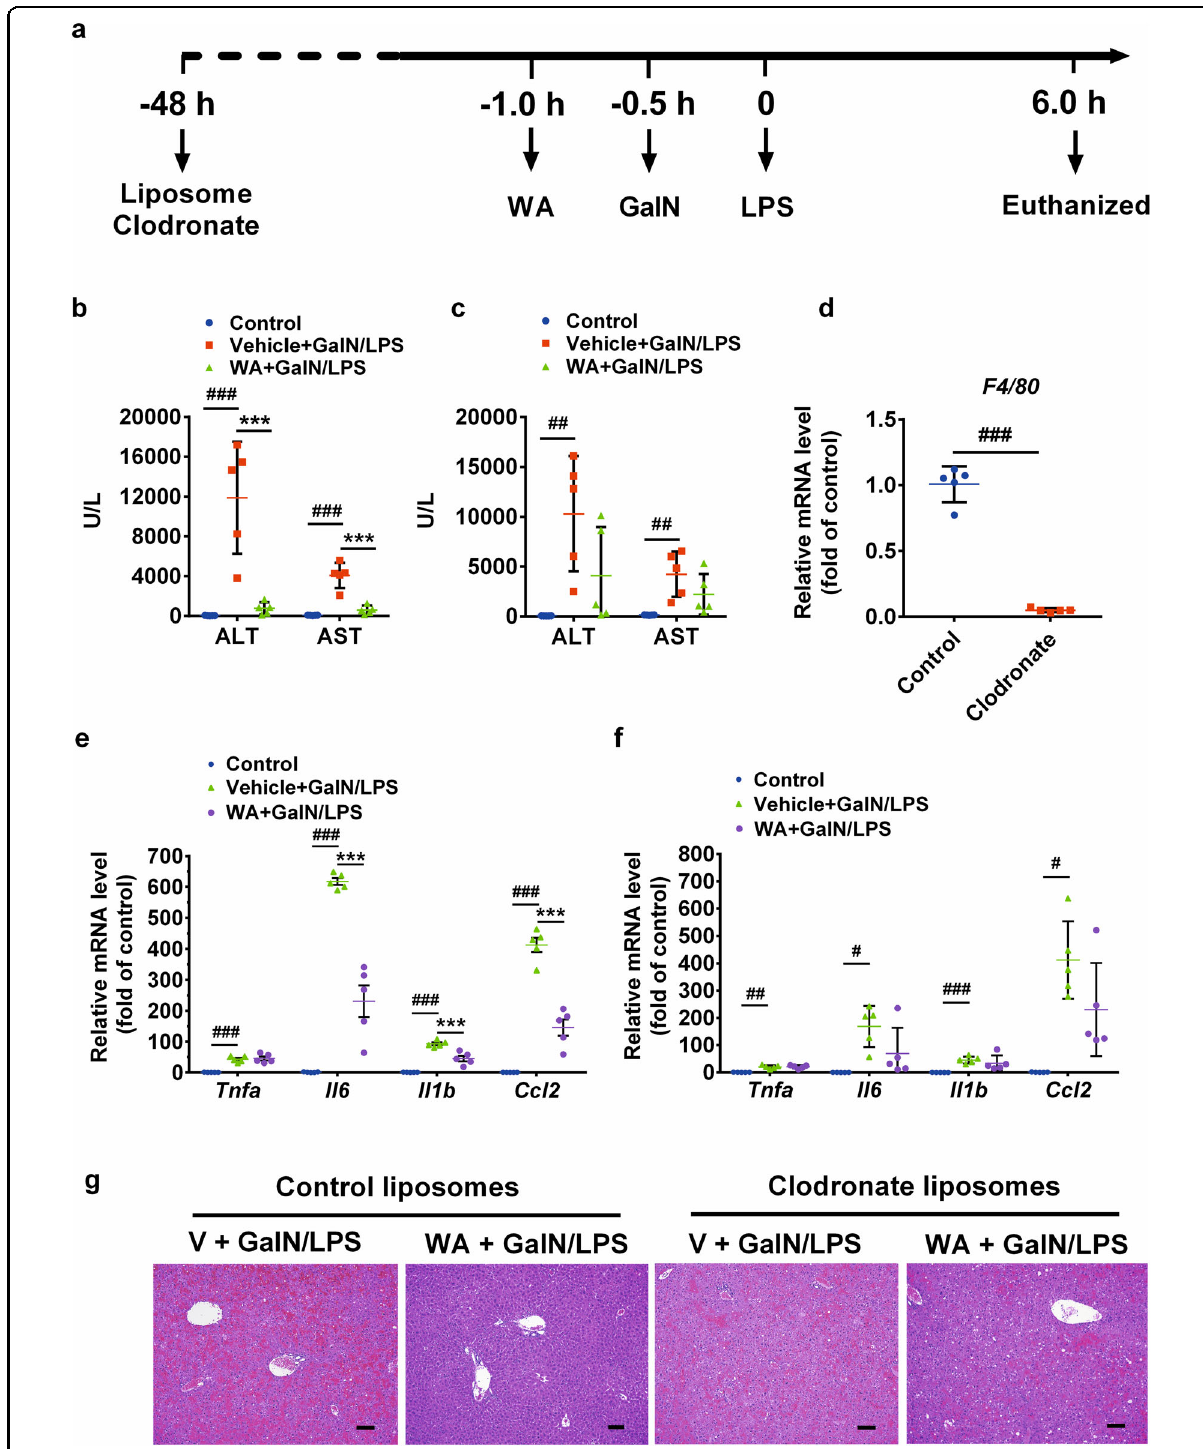
Fig. 5 Hepatoprotective effect of WA was abolished in macrophage-depleted mice. a Experimental time scheme. b Serum ALT and AST levels in control liposomes-pretreated mice. c Serum ALT and AST levels clodronate liposomes-pretreated mice. d Hepatic F4/80 mRNA levels of control or clodronate alone-treated mice. e Hepatic mRNA levels of proin fl ammatory cytokines including Tnfa , Il6 , Il1b , and Ccl2 in control liposomes-pretreated mice. f Hepatic mRNA levels of in fl ammation pathway including Tnfa , Il6 , Il1b , and Ccl2 in clodronate liposomes-pretreated mice. g Representative images of liver H&E staining, scale bar 50 µm. Data are presented as means ± SD, n = 5. Groups were the same as described in Fig. 1 legend. One-way ANOVA was used for statistical analyses. # p < 0.05, ## p < 0.01, and ### p < 0.005 versus Control group; *** p < 0.005 versus V + GalN/LPS